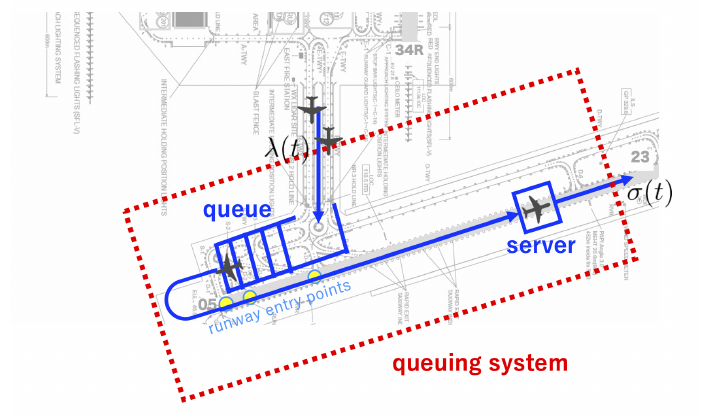
Figure 8. Modeling the RJTT Runway 05 departure